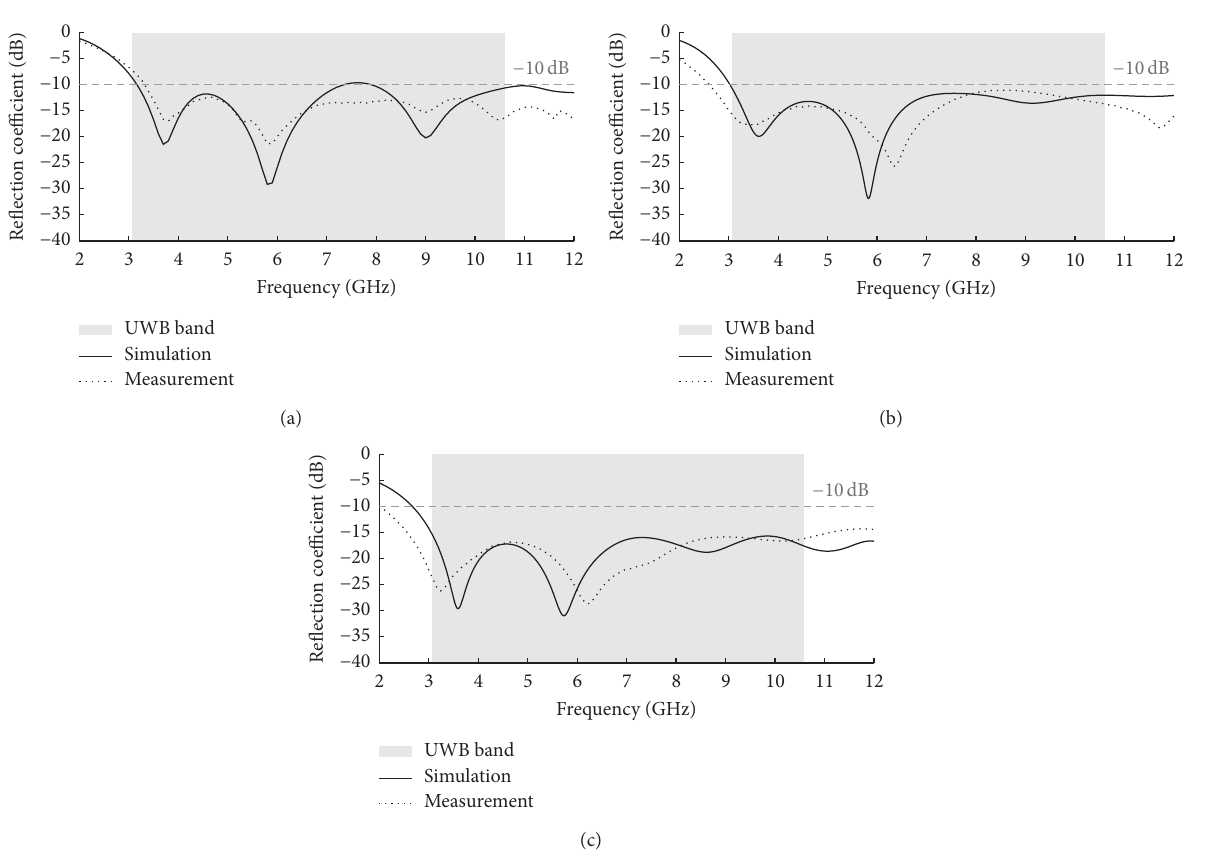
Figure 5: The reflection coefficient of transparent UWB antennas. (a) CUWB. (b) TRUWB. (c)